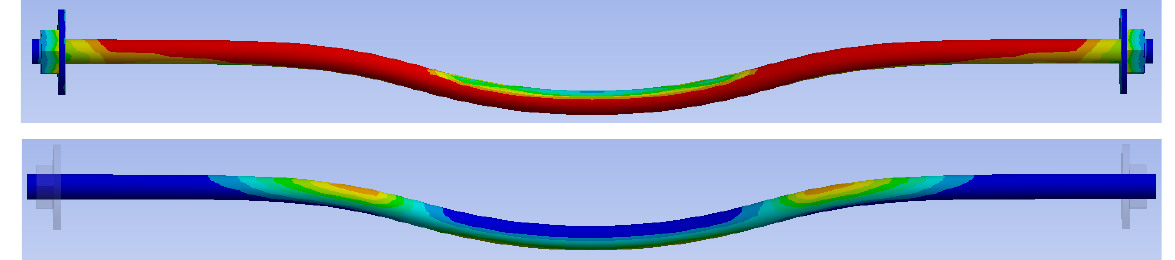
Figure 22. Experiment A: Detailed stress (MPa) ( above ), detailed plastic deformation (-) ( below ) (colour scale valid form the previous figure).